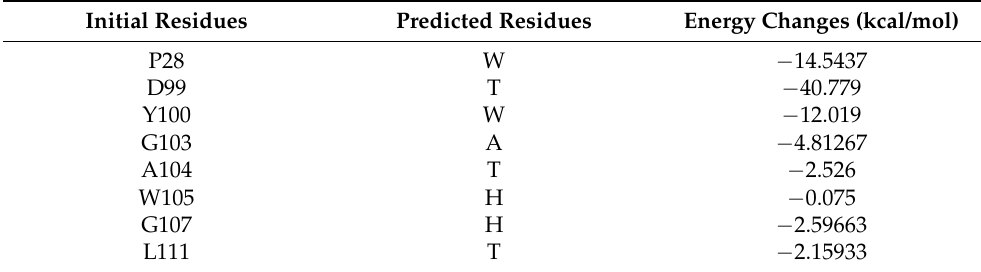
Table 3. Predicted scoring of rosetta residue